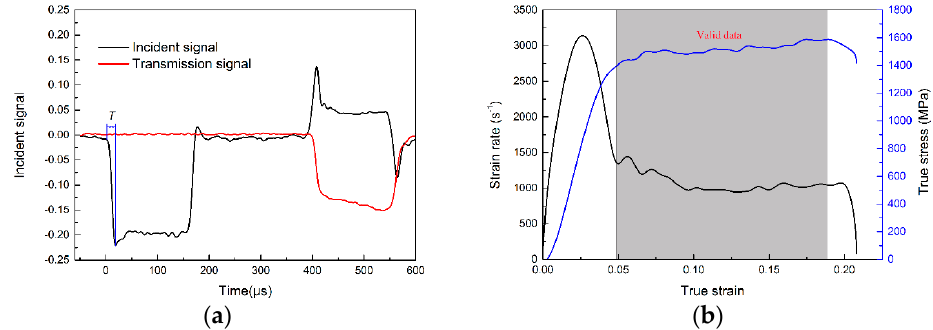
Figure 6. Stress balance and constant strain rate deformation (AM-P-TC-4, 289 K, 1200 s − 1 ): ( a ) Waveform, ( b ) data selection.